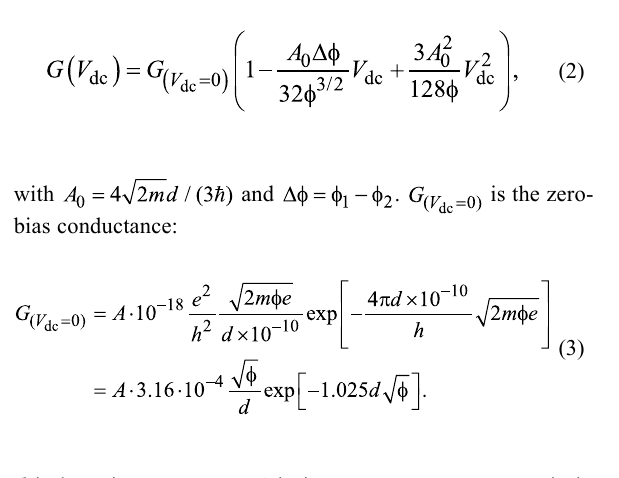
Figure 3a. We arbitrarily set the effective area to A = 100 nm